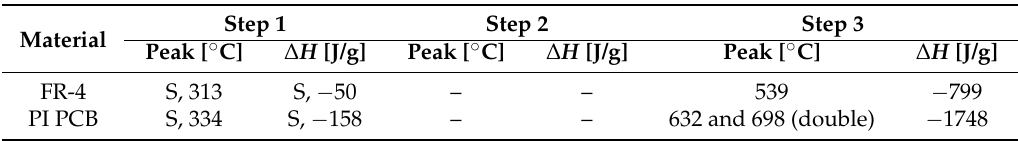
Table 3. Results from DTA measurements.